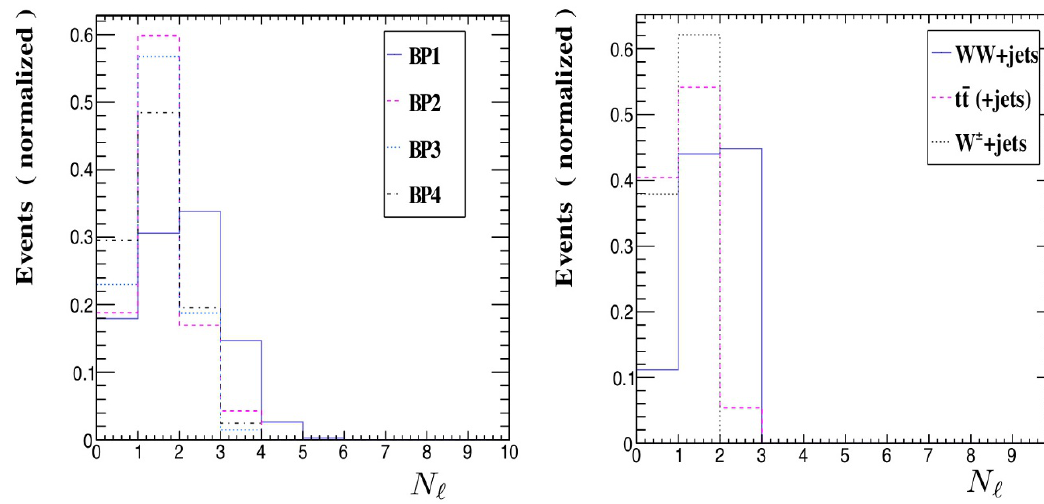
Figure 2 . Parton-level charged lepton multiplicity distributions for the LRSUSY signals (left) and for the dominant SM backgrounds (right), all curves being normalised to